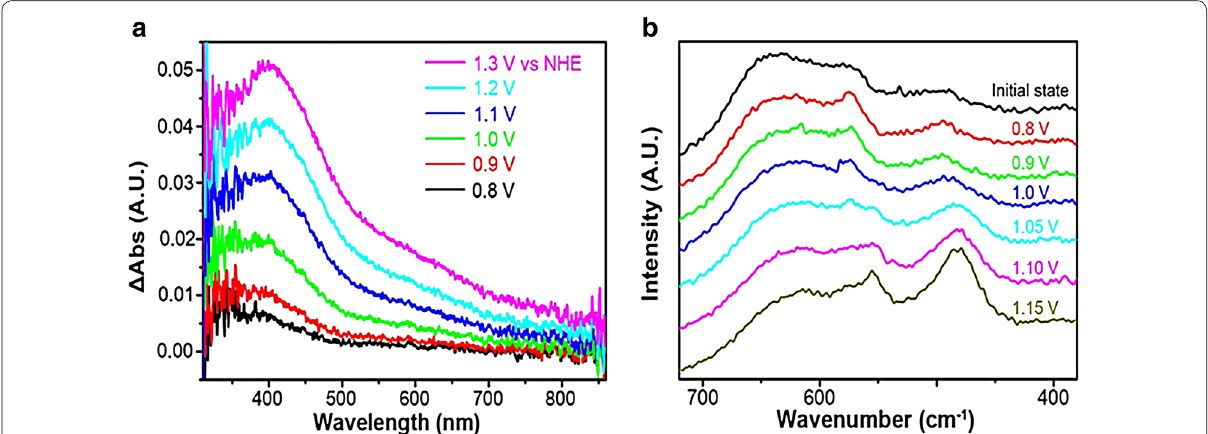
Fig. 5 a In - situ UV–Vis difference spectra of the MnO NPs based on the applied potential. b In - situ Raman spectra of the MnO NPs at various potential collected during bulk electrolysis [105] (Adapted with permission from ref [105]. Copyright 2017, ACS